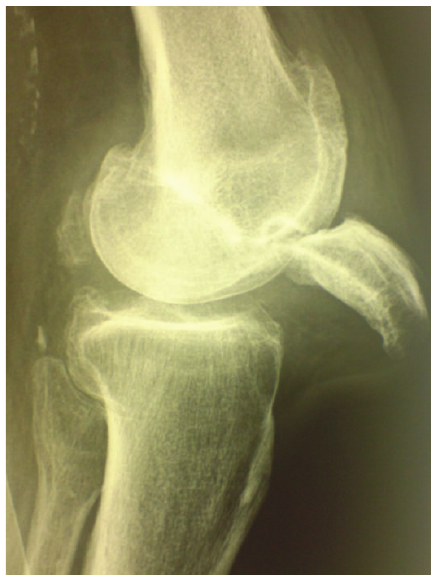
Figure 2: Lateral radiograph of the knee.